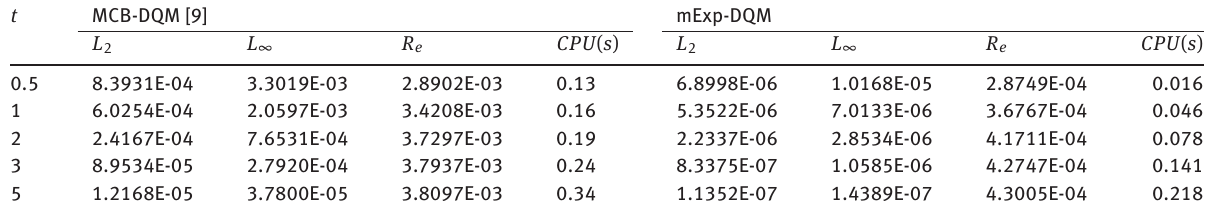
Table 2: Comparison of the mExp-DQM solutions of Example 5.1 with α = 10, β = 5, (cid:2) t = 0.01, h = 0.1 and p =